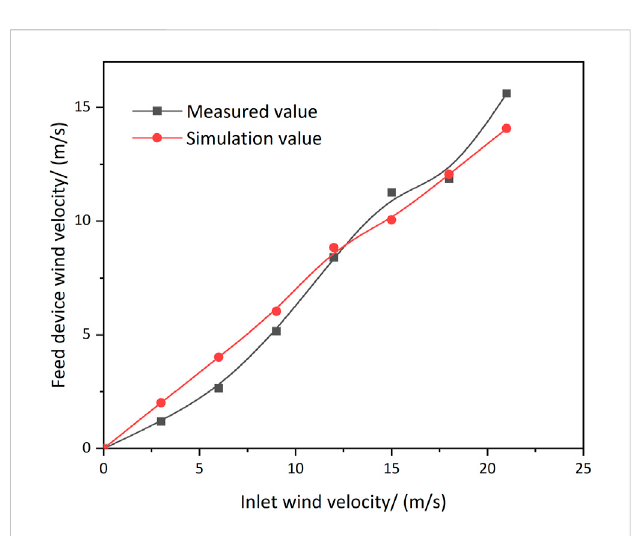
FIGURE 5 Comparison of measured and simulated